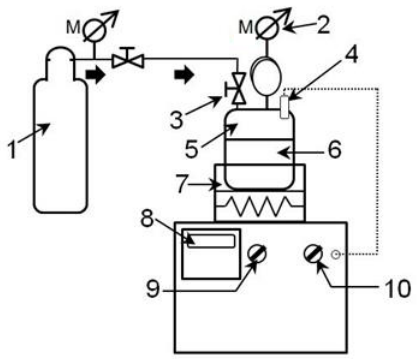
Figure 1. Schematic diagram of subcritical water extraction system: (1) nitrogen cylinder; (2) manometer; (3) input gas valve; (4) thermocouple for temperature measurement; (5) coverlid of extraction vessel; (6) extraction vessel; (7) vibrating platform; (8) digital temperature controller; (9) main switch; (10) switch for the vibrating platform.